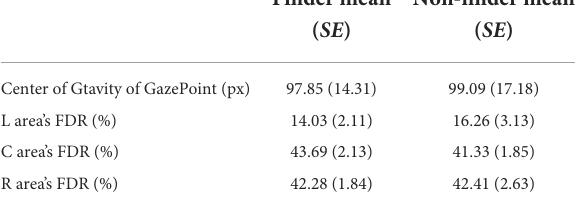
TABLE 1 The mean ( SE ) of the eye movements for each group in the first set trial. Finder mean Non-finder